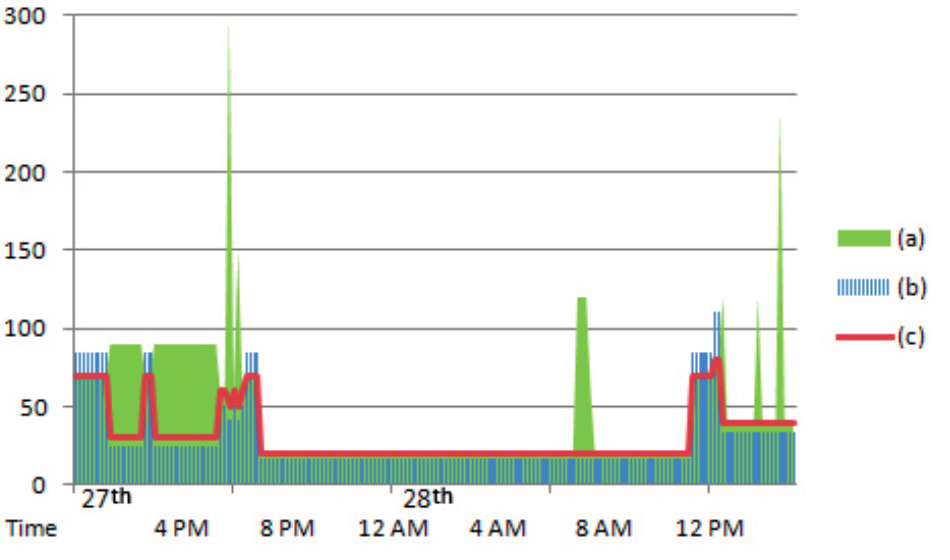
Figure 5. The volunteer’s real-time air pollution exposure, intake, and AQI values during the 27–28 December 2010 data period in Houston, Texas. ( a ) O 3 intake rate (10 − 8 L/min); ( b ) AQI; ( c ) measured O 3 concentration